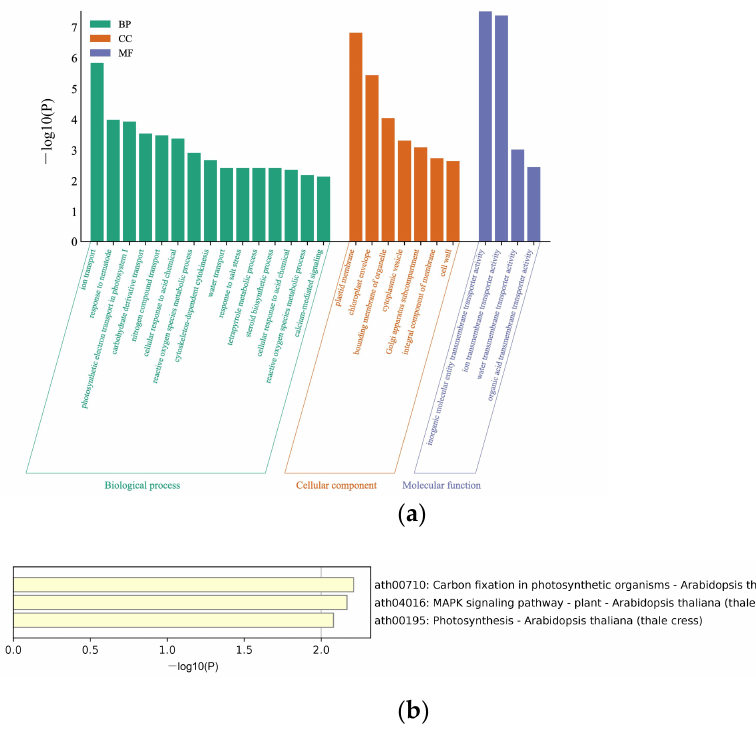
Figure 1. GO term and KEGG enrichment analyses. ( a ) GO functions of screened host factors. The horizontal axis represents the specific terms of biological processes, cellular components, and molecular functions. The vertical axis represents the p -value. The bars represent the GO functions enriched with target proteins; the horizontal coordinates are sorted according to the p -value; ( b ) KEGG pathway enrichment analysis. The horizontal axis represents the p -values of pathways, and the vertical axis represents the